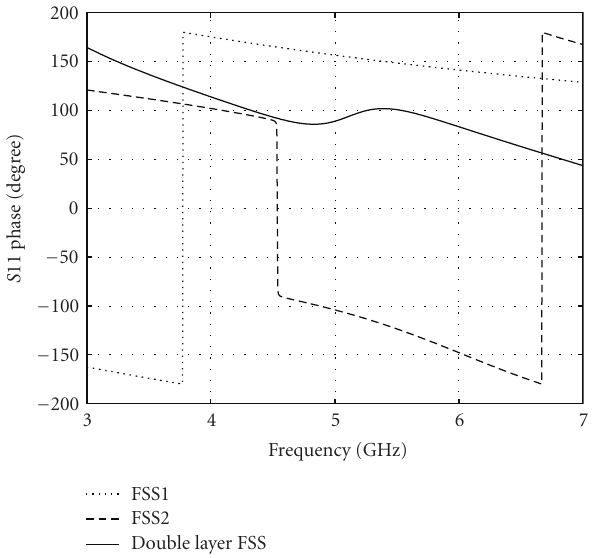
Figure 3: Reflection coe ffi cient phase.